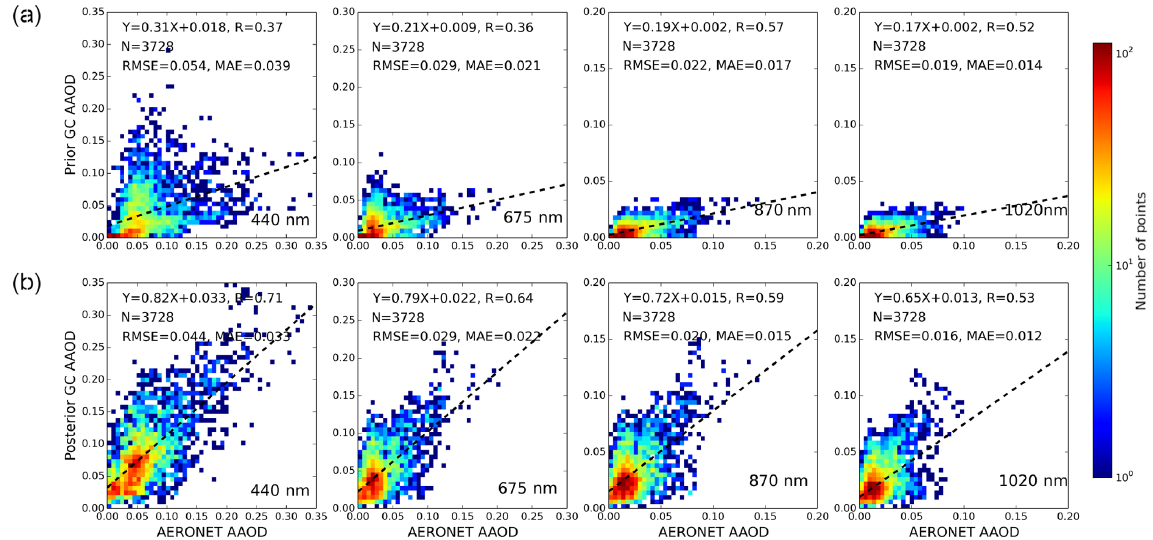
Figure 18. Same as Fig. 17, but for AAOD. The AAOD data were aggregated into 50 bins for both the x and y directions spanning the range from 0.0 to 0.35 for AAOD at 440nm, 0.0 to 0.3 at 675nm, and 0.0 to 0.2 at 870 and